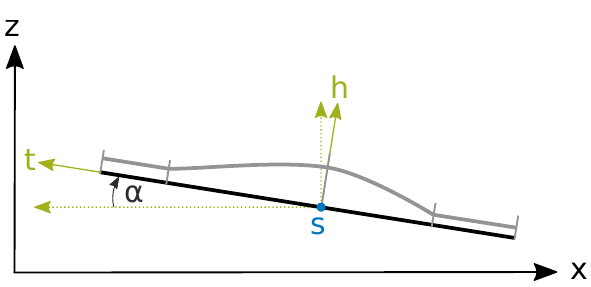
Figure 7. Superelevation α and section-wise defined height functions for the road shape.